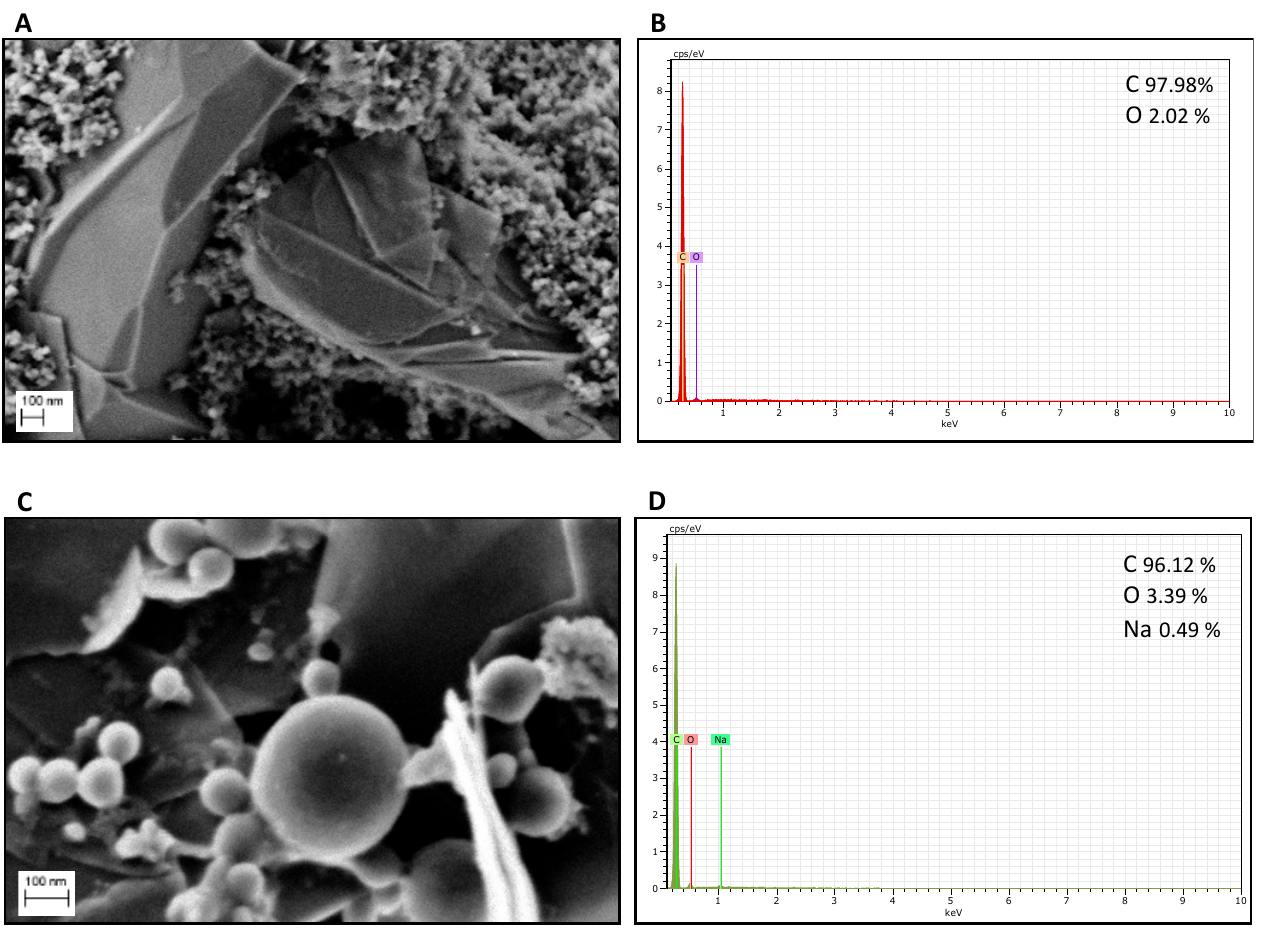
Figure 1. FE-SEM images and EDX spectra for GPH/SPE (Panel ( A , B )) and ChitNPs/GPH/SPE (Panel ( C , D )). Experimental conditions: magnification, 20,000×; voltage, 1.50 kV.